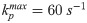
Snapshots of membrane’s protrusion with a wider actin brush underneath the membrane.Upon distribution of actin filaments on a larger region, we obtain lamellipodium-like protrusions for (a) non-progressive and (b) progressive gel boundary. Total number of filaments is 101 and the parameters are kpmax=60s-1, Fe = 12 pN, vgmax=30nm/s and na = 0.02 nm−1.